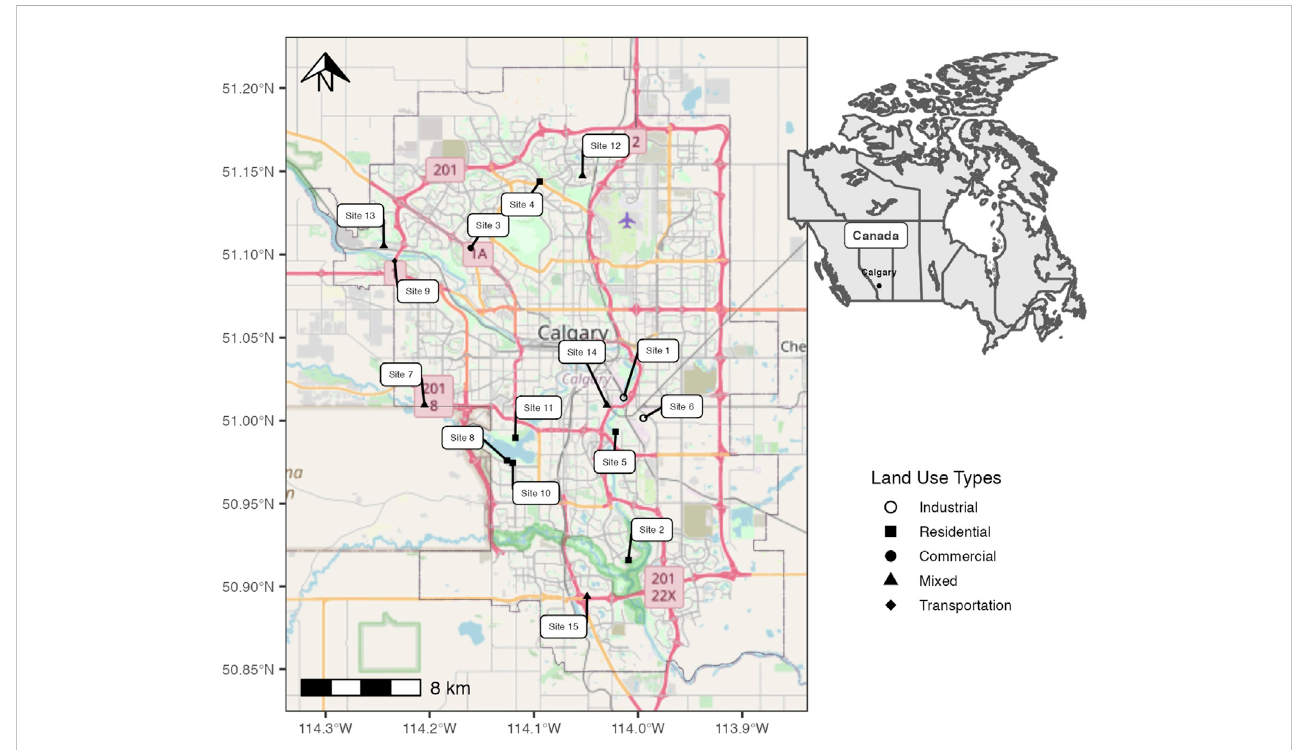
FIGURE 1 Map of Calgary, Alberta, showing stormwater sampling locations throughout the